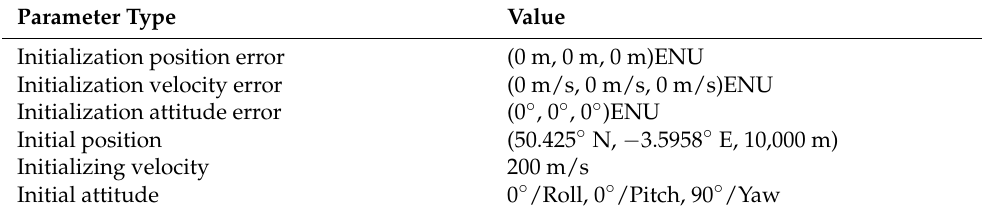
Table 2. Initial parameter setting of orbit.